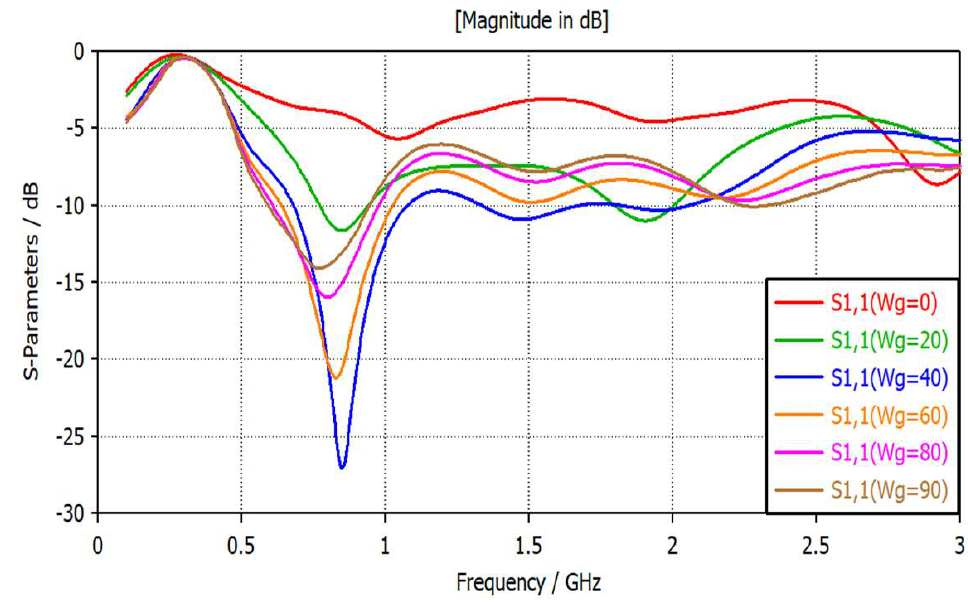
Figure 4. Return losses vs. frequency for different values of w g